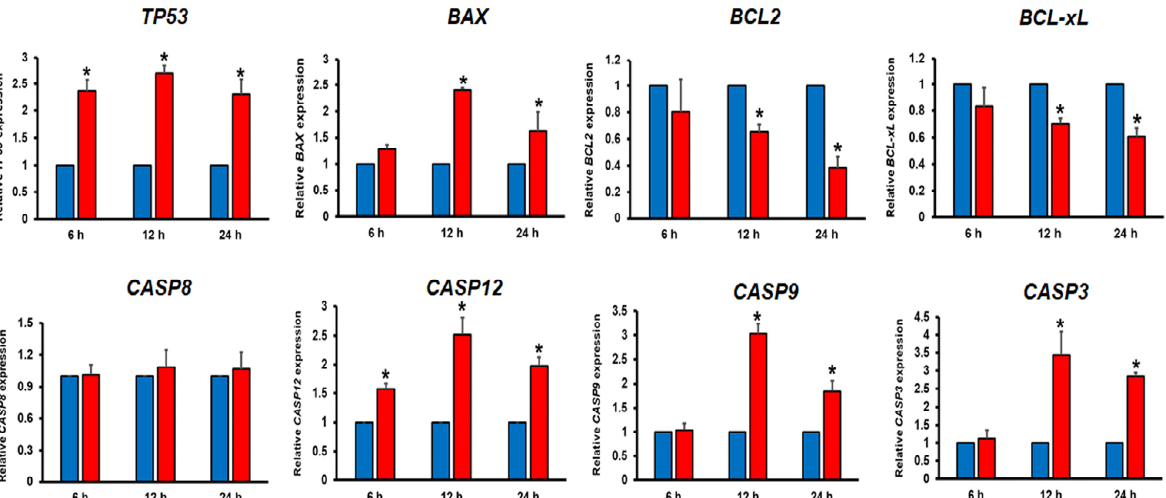
Figure 5. Effects of OAEO on apoptosis-related gene expression in AGS-treated cells. Expression levels of TP53 , BAX , BCL2 , BCL-xL , CASP8 , CASP12 , CASP9 , and CASP3 were determined by qRT– PCR at 6, 12, and 24 h (blue bars: untreated control; red bars: OAEO treatment). Relative gene expression data are presented as mean ± SD. * p < 0.05 vs. vehicle control cells.